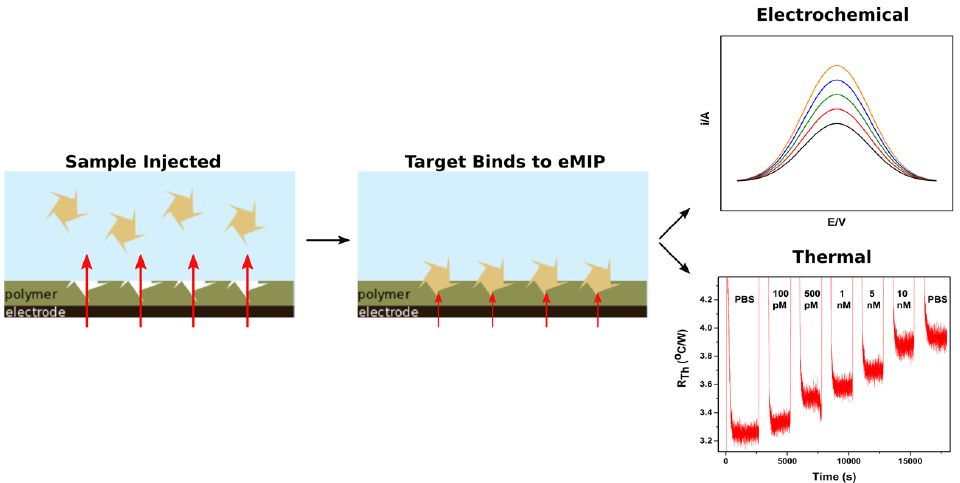
Figure 2. Schematic of the typical development of an eMIP based sensing platform with two examples of detection read out. The template is first mixed with the monomer solution, then using either the constant potential or cyclic voltammetry. The template is then removed from the polymer layer. Upon the addition of sample, the target rebinds to the polymer layer, which can be measured through various techniques, such as voltammetry or thermal